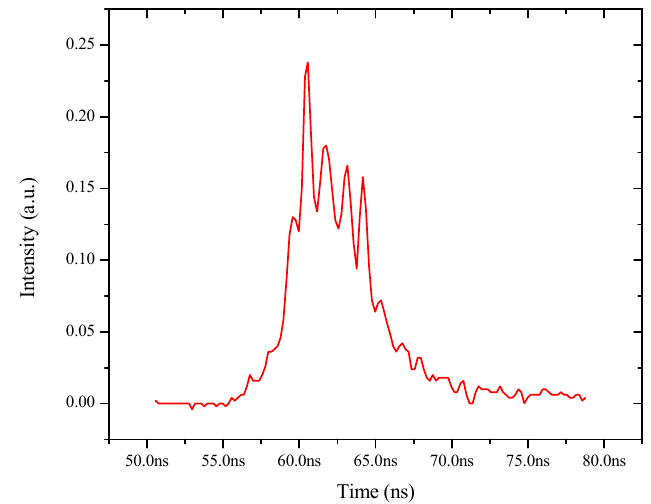
Figure 6. Shows the temporal profile of ASE for pump pulse energy (4 mJ) well above threshold, one could see the emission become jittery with spikes of 600 ps attributed the relaxation oscillation.